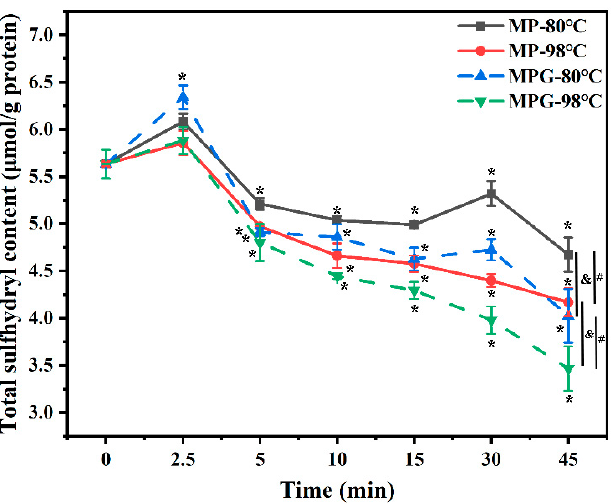
Figure 3. Changes in total sulfhydryl content of myofibrillar protein and glucose (MPG) and myofib- rillar protein (MP) under different heating conditions (80 ◦ C and 98 ◦ C, 0–45 min). Error bars indicate standard deviation (n = 3). Samples with * p < 0.05 indicate significant differences at different heating times (compared with 0 min). Samples with # p < 0.05 indicate significant differences between 80 ◦ C and 98 ◦ C. Samples with & p < 0.05 indicate significant differences between MPG and